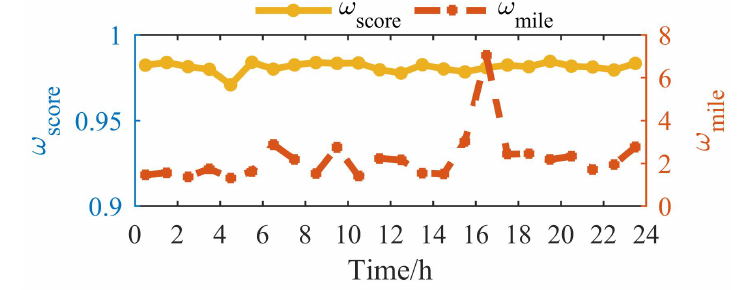
Figure A2. ω score and ω mile .